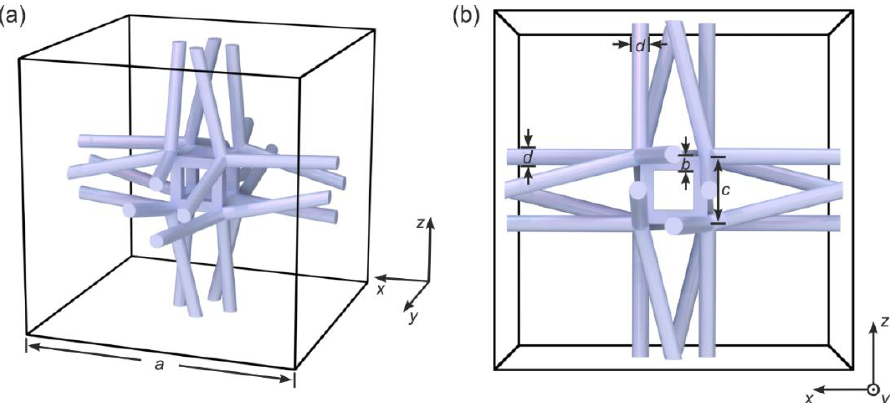
Figure 1. ( a ) and ( b ) are different views onto the blueprint of one cubic unit cell of the 3D chiral mechanical metamaterial lattice considered here. The indicated geometrical parameters are: 𝑎 = 250 µm , 𝑏 = 10 µm , 𝑐 = 50 µm , and 𝑑 = 6.25 µm . Parameters of the constituent polymer material are: Young’s modulus (or storage modulus) 𝐸 = 4.18 GPa , Poisson’s ratio 𝜈 = 0.4 , and mass density 𝜌 = 1.15 g/cm 3 (cf. [21]). For some of the calculations, we have added an imaginary part (or loss modulus) of 0.20 GPa to the quoted real part of the polymer Young’s modulus. Whenever applicable, we will explicitly mention this finite imaginary part, which describes damping of the elastic waves.